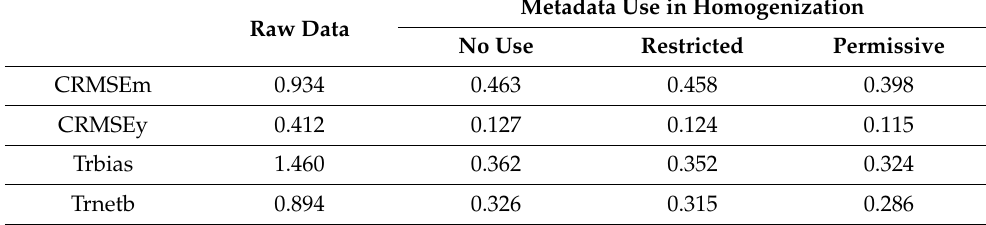
Table 1. Average errors for all homogenization experiments. CRMSE are in ◦ C, trend biases are in ◦ C/100 years unit.